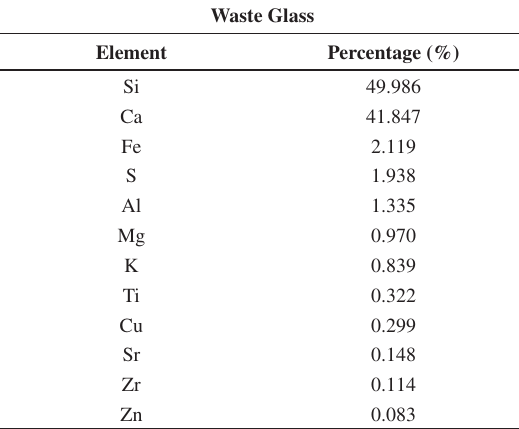
Table 1. Chemical analysis of waste glass by EDXRF.